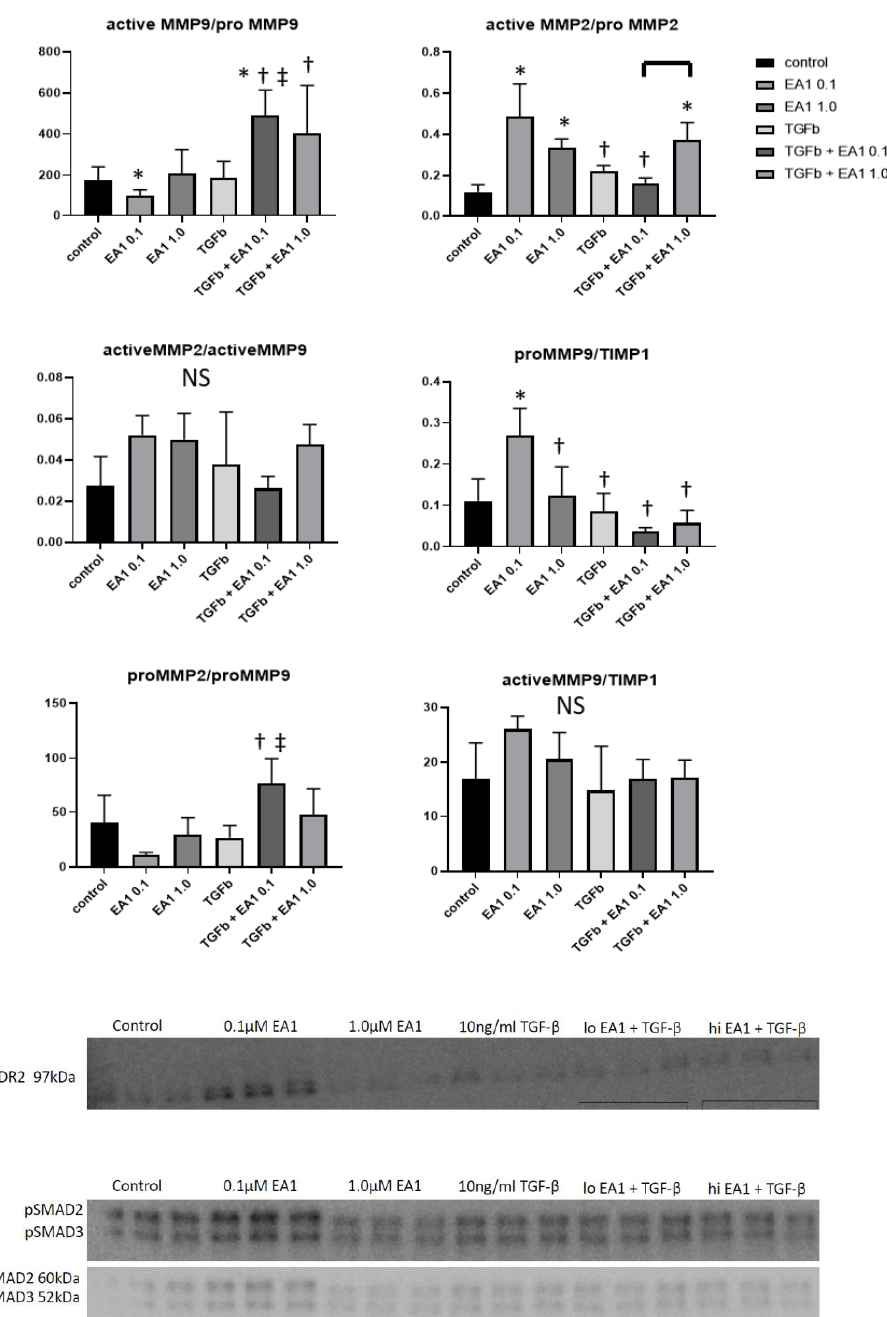
Figure 7. Expression Changes in MMP-2, MMP-9, TIMP1, DDR2 and (p)SMAD2 / 3 / total SMAD2 / 3 in B6 and EphA2-R-M Mouse Hearts. MMP-9, MMP-2 and TIMP-1 expression in ephrinA1-Fc-treated +/ -TGF- β primary cardiac fibroblasts are modulated in a dose-dependent manner ( n = 3 / group; significance: * vs. control, † vs. 0.1 µ M EA1, ‡ vs. TGF- β ). Western blots of DDR2 and (p)SMAD2 / 3 / totalSMAD2 / 3 show dose-dependent changes in response to ephrinA1-Fc-treatment +/ -TGF- β